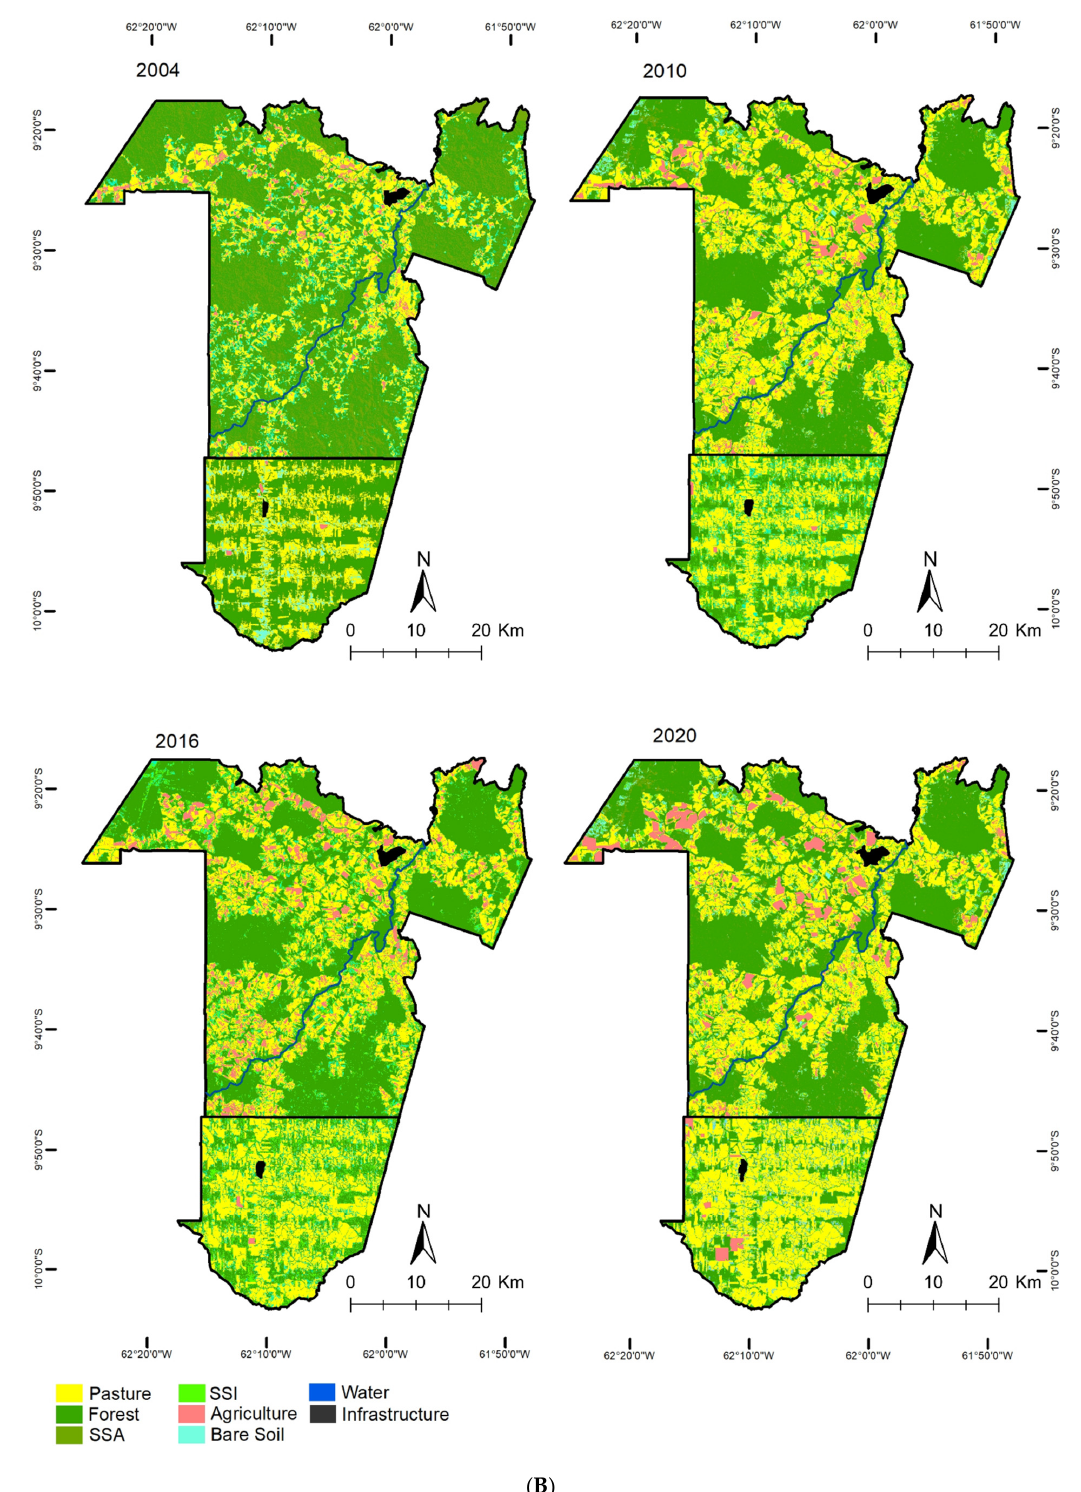
Figure 3. ( A ). LULC in the settlements of Machadinho and Anari with open tropical forest (forest), advanced secondary succession (SSA), initial secondary succession (SSI), production (agriculture, pasture, bare soil), water and infrastructure from 1984 to 1999. ( B ). LULC in the settlements of Machadinho and Anari with open tropical forest (forest), advanced secondary succession (SSA), initial secondary succession (SSI), production (agriculture, pasture, bare soil), water and infrastructure from 2004 to